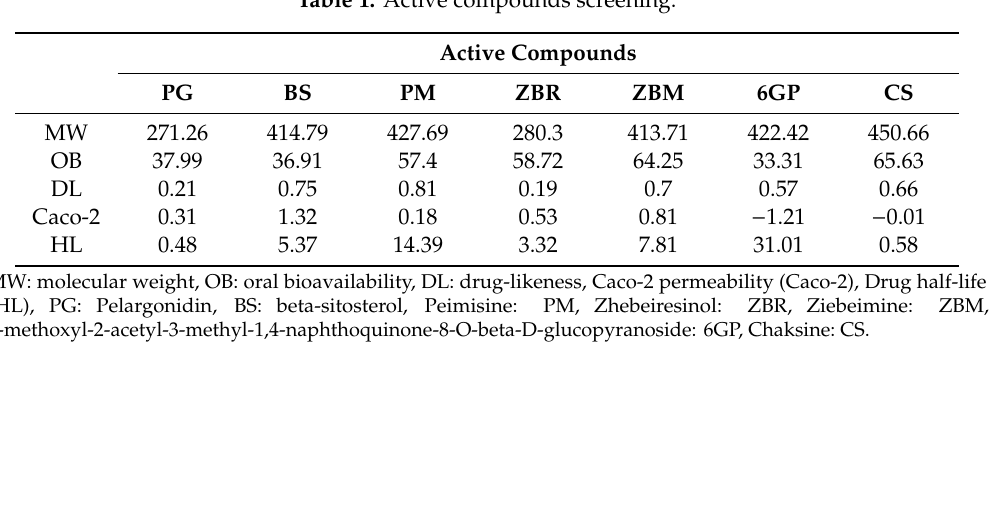
(CS) (Table 1). Based on seven compounds, Caco-2 permeability (Caco-2) and drug half-life (HL) data were collected to determine pharmacokinetics of FT compounds. Our results indicated that BS showed the highest permeability and drug half-life. Table 1. Active compounds